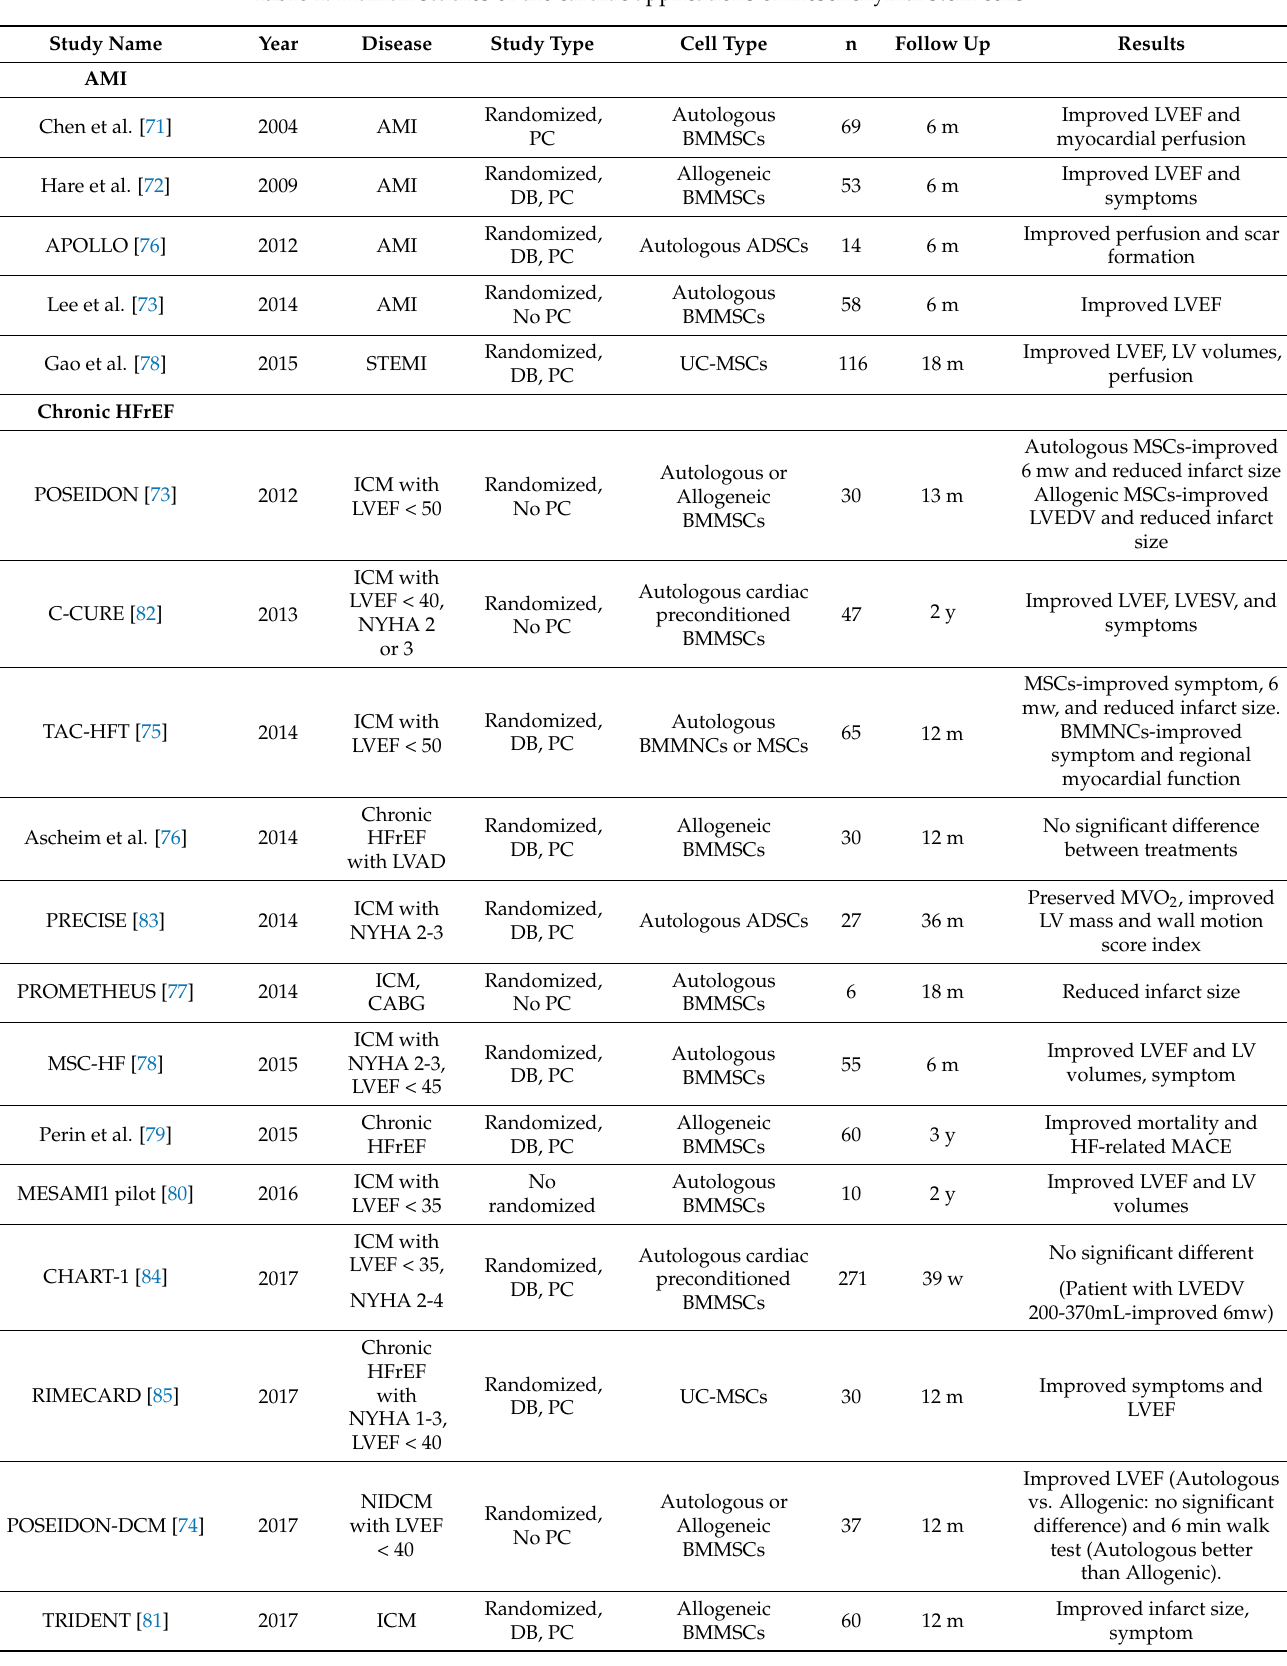
Table 1. Human studies of the cardiac applications of mesenchymal stem